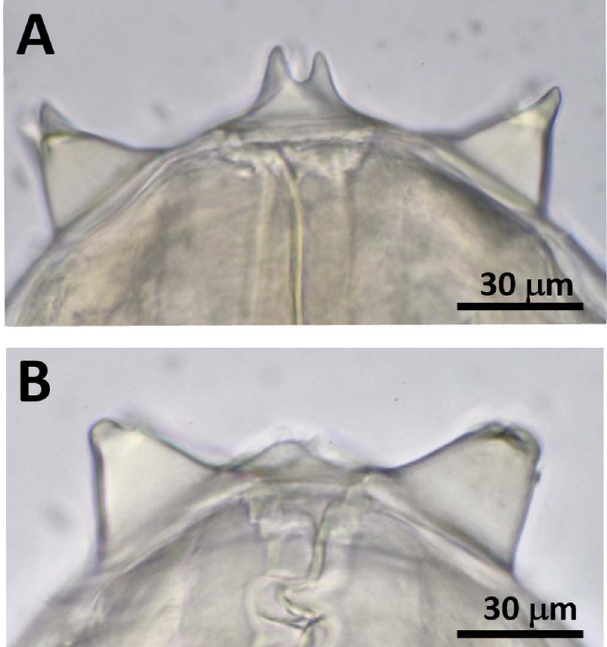
Figure 1. (A) Lateral lips of a female and (B) a male nematode.